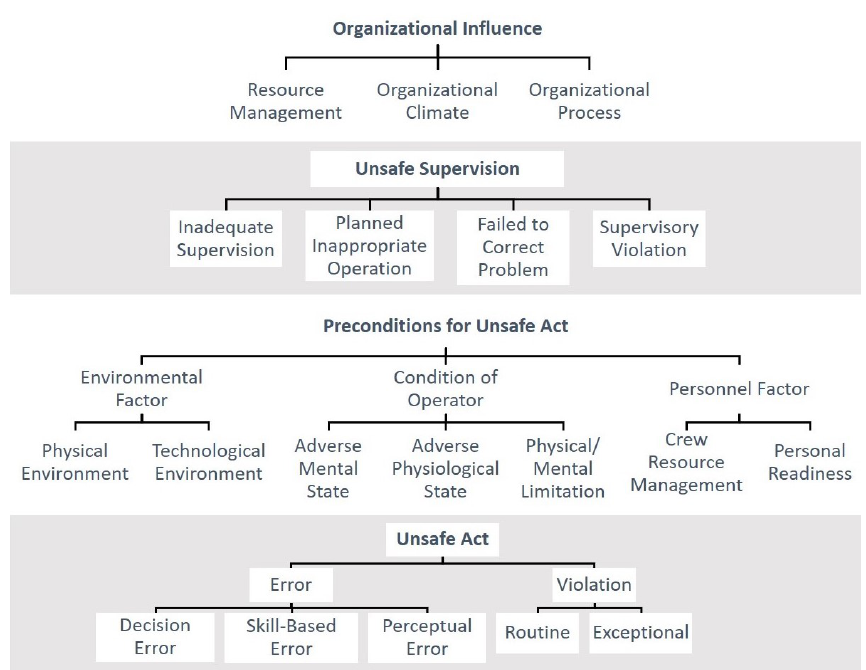
Figure 3. Human Factor Analysis and Classification System (HFACS) framework (adapted from [24]).